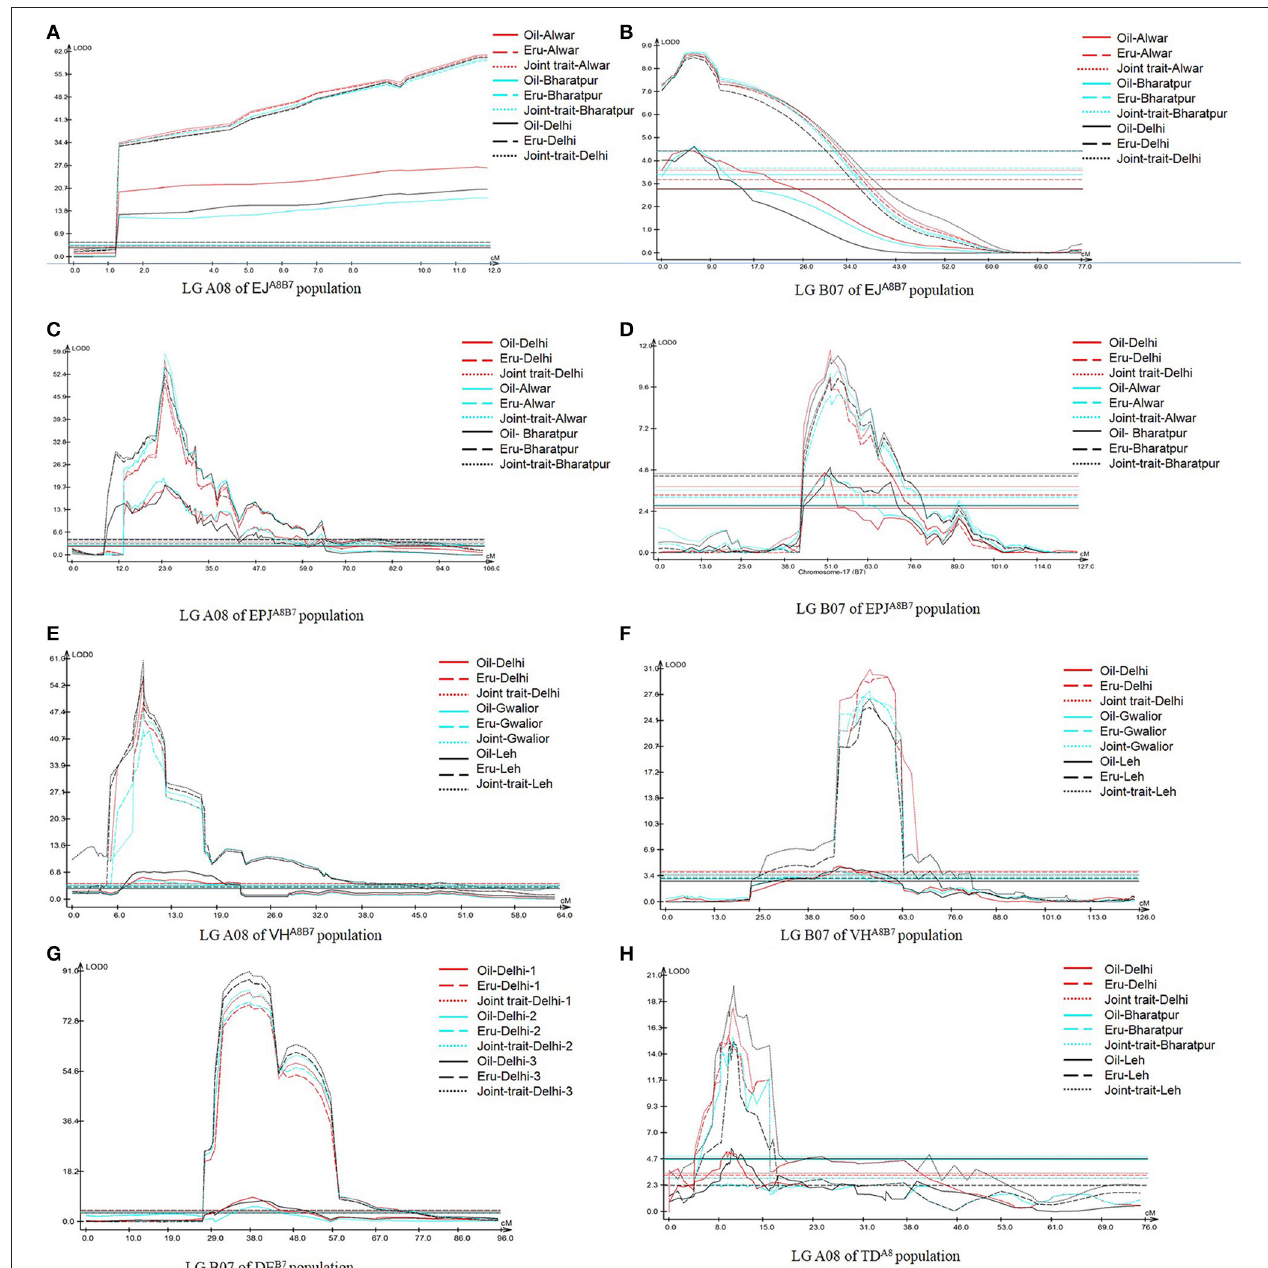
FIGURE 3 | Multi-trait mapping (Mt-CIM) of seed oil content and erucic acid content in five SE bi-parental mapping populations of B. juncea showing pleiotropism between erucic acid and oil content ( A : LG A08 of EJ8 A8B7 population, B : LG B07 of EJ8 A8B7 population, C : LG A08 of EPJ A8B7 population, D : LG B07 of EPJ A8B7 population, E : LG A08 of VH A8B7 population, F : LG B07 of VH A8B7 population, G : LG B07 of DE B7 population, and H : LG A08 of TD A8 population). The horizontal lines indicate LOD significance